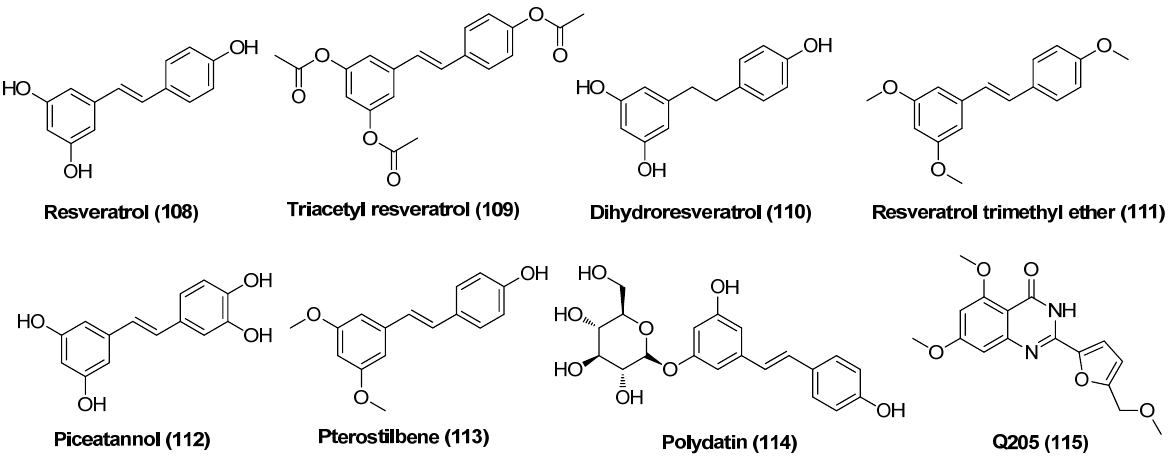
Figure 28. The chemical structure of several polyphenols. Resveratrol (108) and its analogue, triacetyl resveratrol (109), displayed clear HIV-1 reactivation potencies.